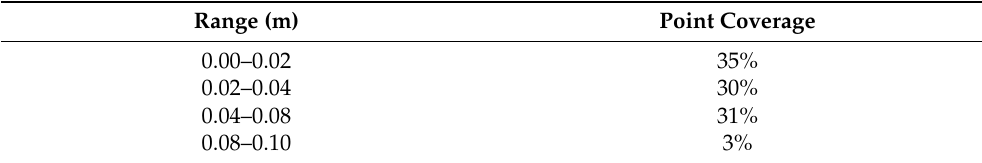
Table 8. C2C analysis P1-SX10: point coverage related to a range of distances.